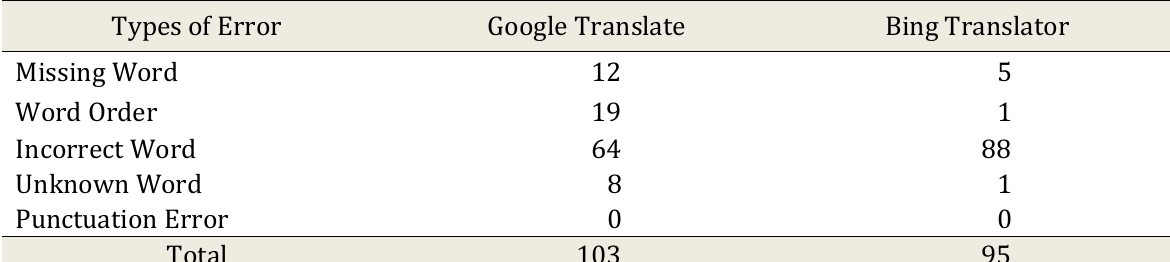
Table 1. Total Errors Found in Google Translate and Bing